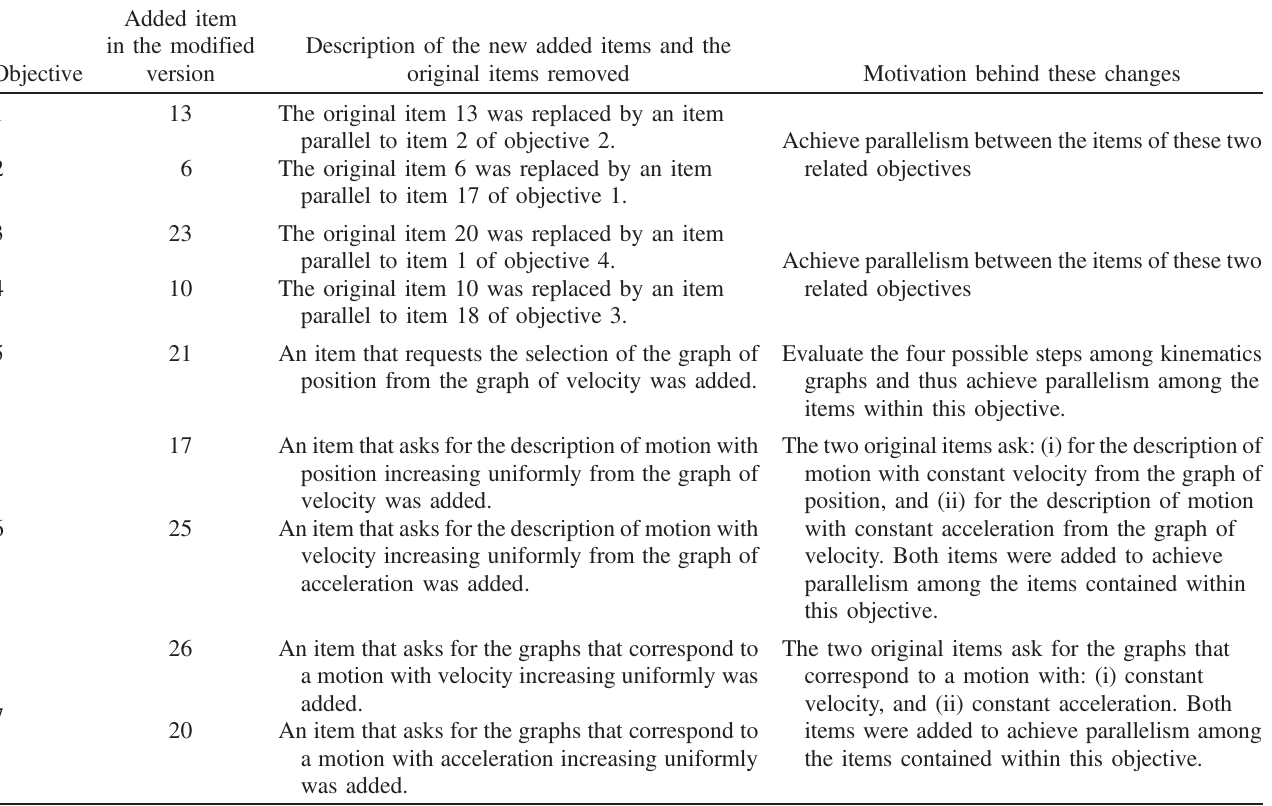
TABLE V. Description of the new added items and the original items removed of each objective, and the motivation behind these changes. Note that the modified version assesses the same seven objectives as the original version (see Table